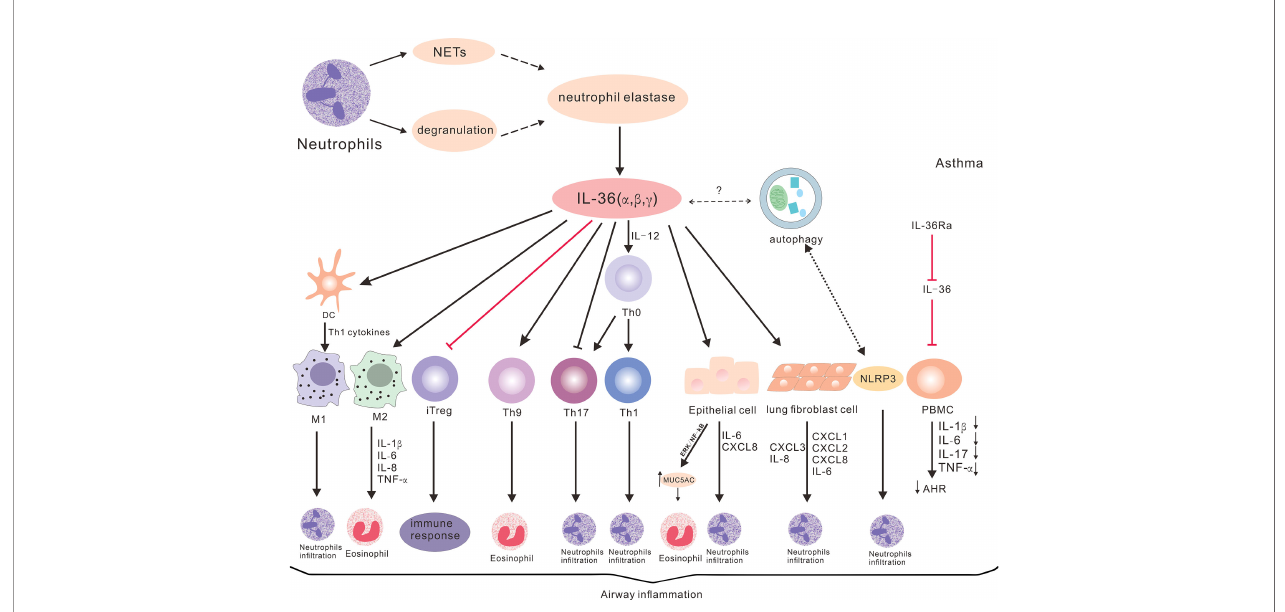
FIGURE 2 | The potential roles of IL-36 cytokines in asthma. IL-36 cytokines promote Th1, Th17 and Th9 differentiation, and inhibit iTreg differentiation. These also enhance the production of cytokines and chemokines through lung epithelial cells, fi broblasts and macrophages, and promote neutrophil and eosinophil in fl ammation to participate in the pathogenesis of various subtypes of asthma. Neutrophil degranulation or NET-derived proteases can promote IL-36 cytokine cleavage, thereby promoting in fl ammatory response. IL-36 cytokines can also regulate autophagy and NLRP3, but the speci fi c roles in asthma remain to be elucidated. IL-36Ra can reduce the production of cytokines, AHR and airway in fl ammation, and the in fl ammatory response of